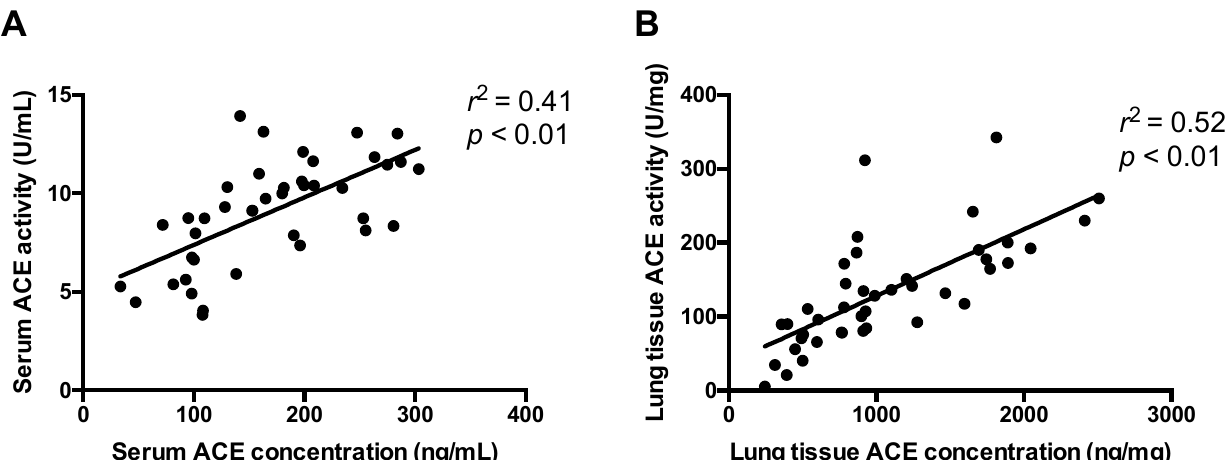
Figure 4. There is a positive correlation between the activity and concentration in the same samples. ACE activity and concentration was measured in the same serum ( A ) and tissue ( B ) samples. Activity was plotted as a function of the concentration. A linear regression was used to establish the correlation between activity and expression. The goodness of fit is represented by the r 2 values, while significance of the correlations by p values. Each symbol represents individual values. Linear fits are shown by the line in the graphs.